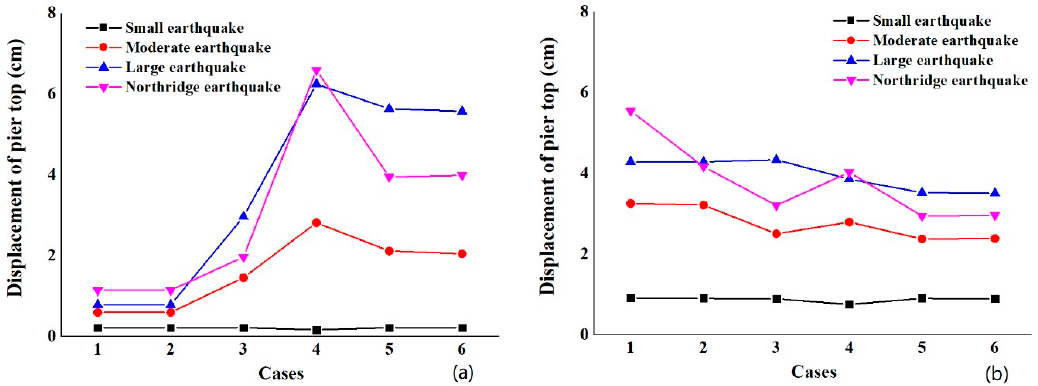
Figure 9. Displacement of the pier top in different cases under different earthquakes: ( a ) side piers and ( b ) middle piers.